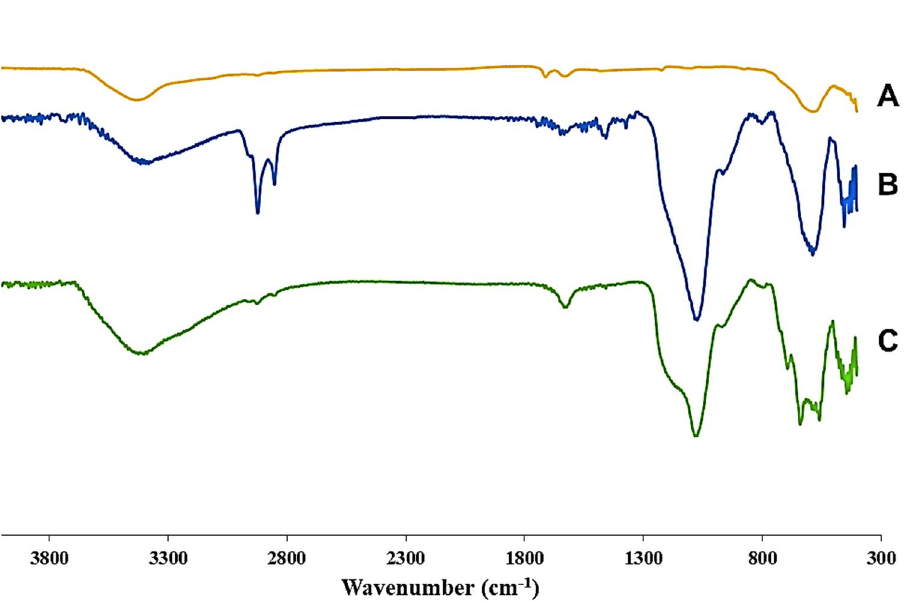
Figure 8. FT-IR results of Fe 3 O 4 ( A ), Fe 3 O 4 @Void@m.SiO 2 nanomaterial before ( B ) and after ( C )